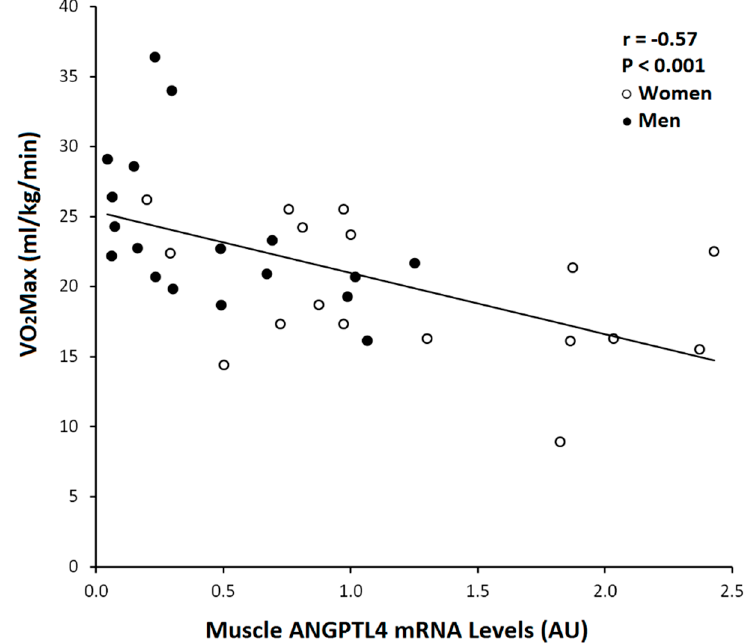
Figure 4. Relationship between muscle ANGPTL4 mRNA level and VO 2 max (Total: n = 35, Women ○ : n = 17, Men ● : n = 18; r = 0.57, p < 0.001) at baseline. Table 3. Relationship between skeletal muscle ANGPTL4 mRNA and metabolic variables.